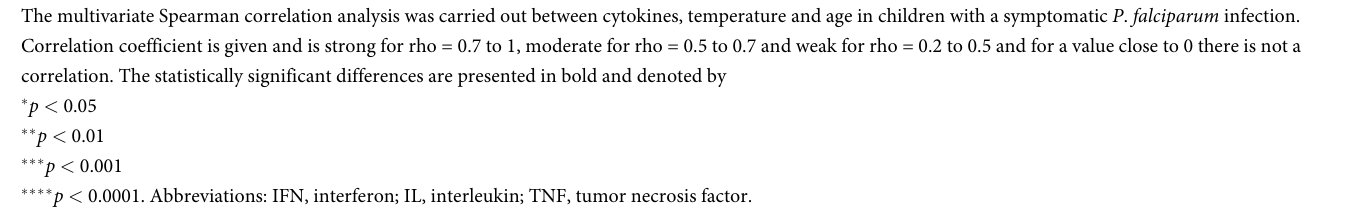
The multivariate Spearman correlation analysis was carried out between cytokines, temperature and age in children with a symptomatic P . falciparum infection. Correlation coefficient is given and is strong for rho = 0.7 to 1, moderate for rho = 0.5 to 0.7 and weak for rho = 0.2 to 0.5 and for a value close to 0 there is not a correlation. The statistically significant differences are presented in bold and denoted by